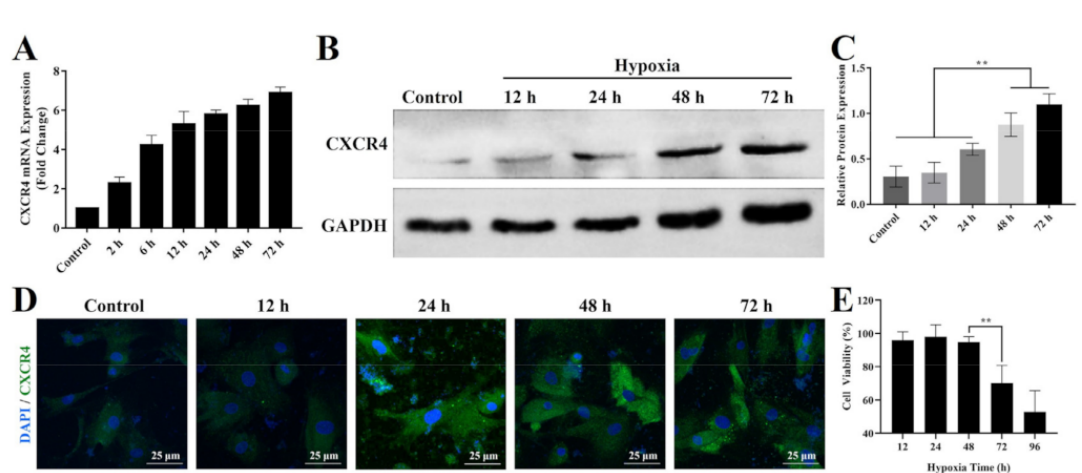
Figure 2. Construction and characterization of hypoxia-engineered bMSCs. mRNA detection of CXCR4 in H-bMSCs at various hypoxia times ( A ); expression of CXCR4 in H-bMSCs at different hypoxia times ( B ); the quantitative analysis of CXCR4 ( C ); immunofluorescence images of CXCR4 ( D ); cell viability of bMSCs at different hypoxia times ( E ). (** p <